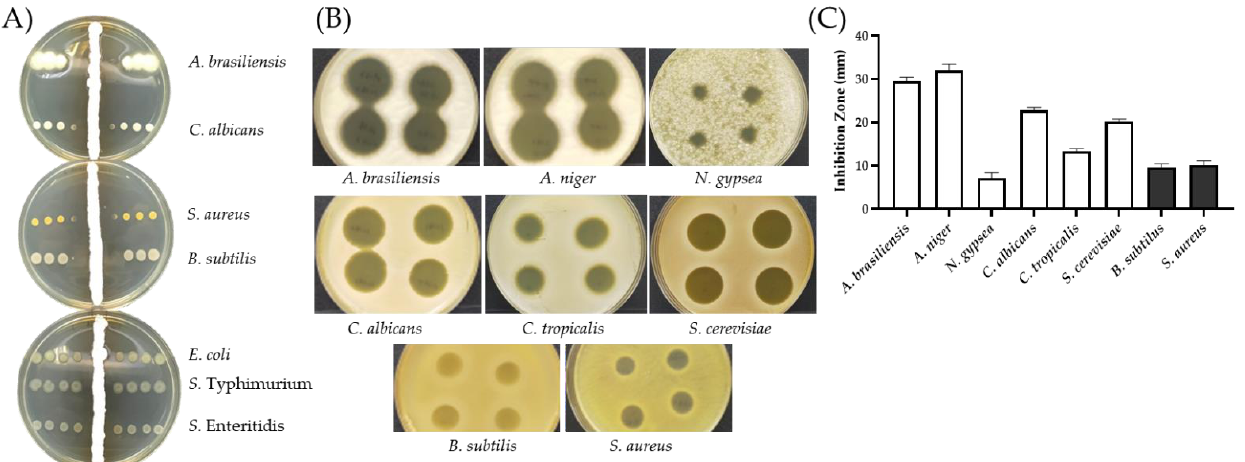
Figure 4. Antibacterial and antifungal activities of SC263. ( A ) Antibiotic activity of SC263 using cross-streak method for a 6-day incubation. An aliquot of 1 μL of bacterial suspension containing 10 3 CFU were spotted cross the central line of SC263. ( B ) 10 μL of SC263 culture suspension was spotted in quadruplicates on lawns of test fungi and bacteria. A. brasiliensis , A. niger , and N. gypsea , was seeded with 10 6 CFU each plate. The rest was seeded with 10 5 CFU. ( C ) The diameters of inhibition zones were measured in triplicate. The error bars are calculated based on the quadruplicate zones for each tested microbe. White columns indicate fungi and black as Gram-positive bacteria.